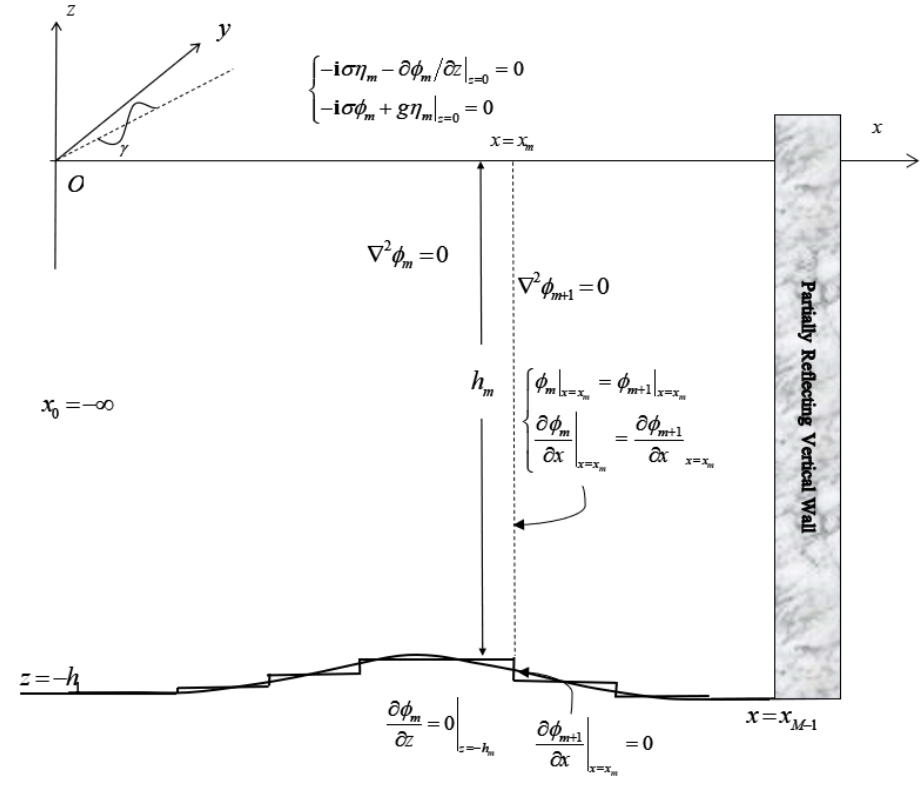
Figure 1. Wave scattering by variable bottoms near a partially reflecting vertical wall.